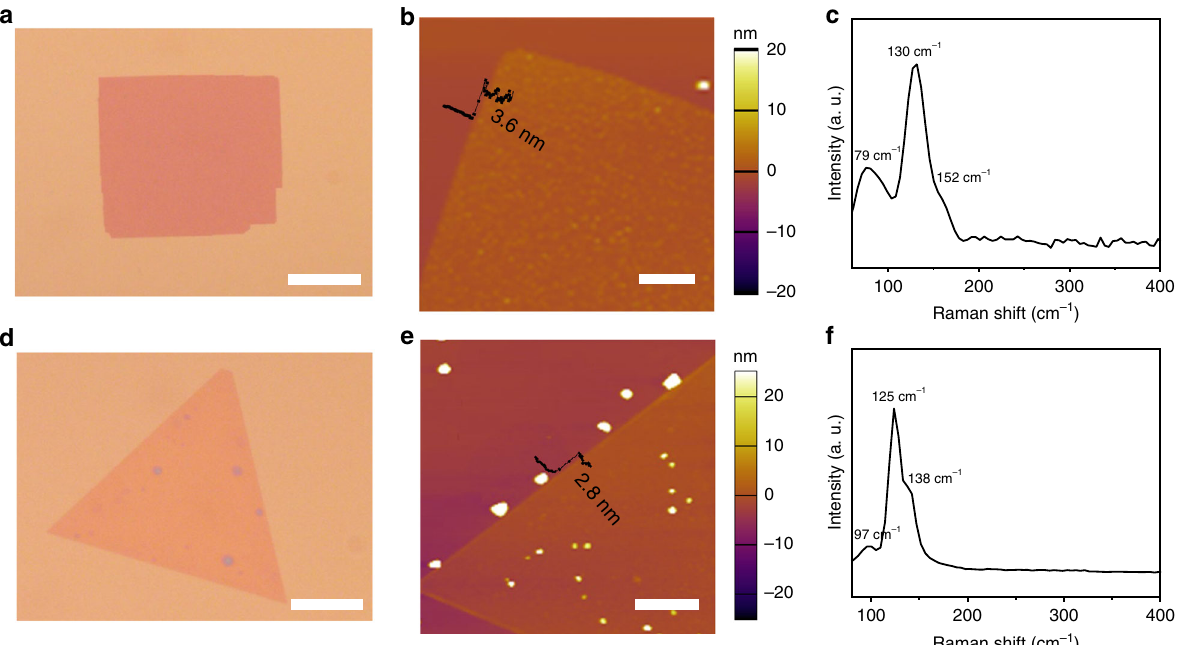
Fig. 2 Morphological and structural characterization of the as-synthesized FeTe samples. a , d Typical optical images of as-grown tetragonal ( a ) and hexagonal ( d ) FeTe crystals on SiO 2 /Si substrates. b , e AFM images of the square FeTe nanoplate with a thickness of 3.6nm and the trigonal FeTe nanoplate with a thickness of 2.8nm. c , f Typical Raman spectra of tetragonal and hexagonal FeTe nanoplates. Scale bars: 20 μ m in a , d ; 2 μ m in b ; 3 μ m in e